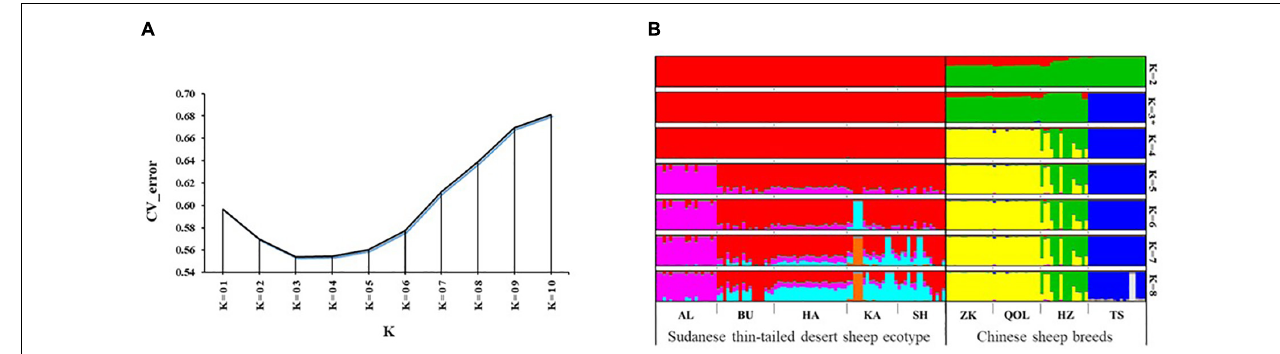
FIGURE 3 | (A) CV plot of the admixture analysis involving all the samples analyzed in the study. (B) Admixture plot showing the assignment probabilities of all the individuals analyzed in the current study for 2 ≤ K ≤